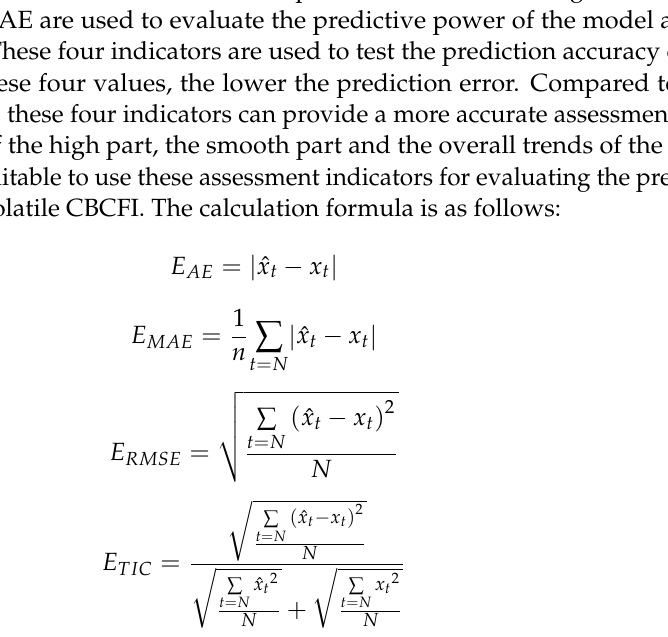
Figure 6. Comparison between forecasting result of ARMA-GM-GABP model and real value.